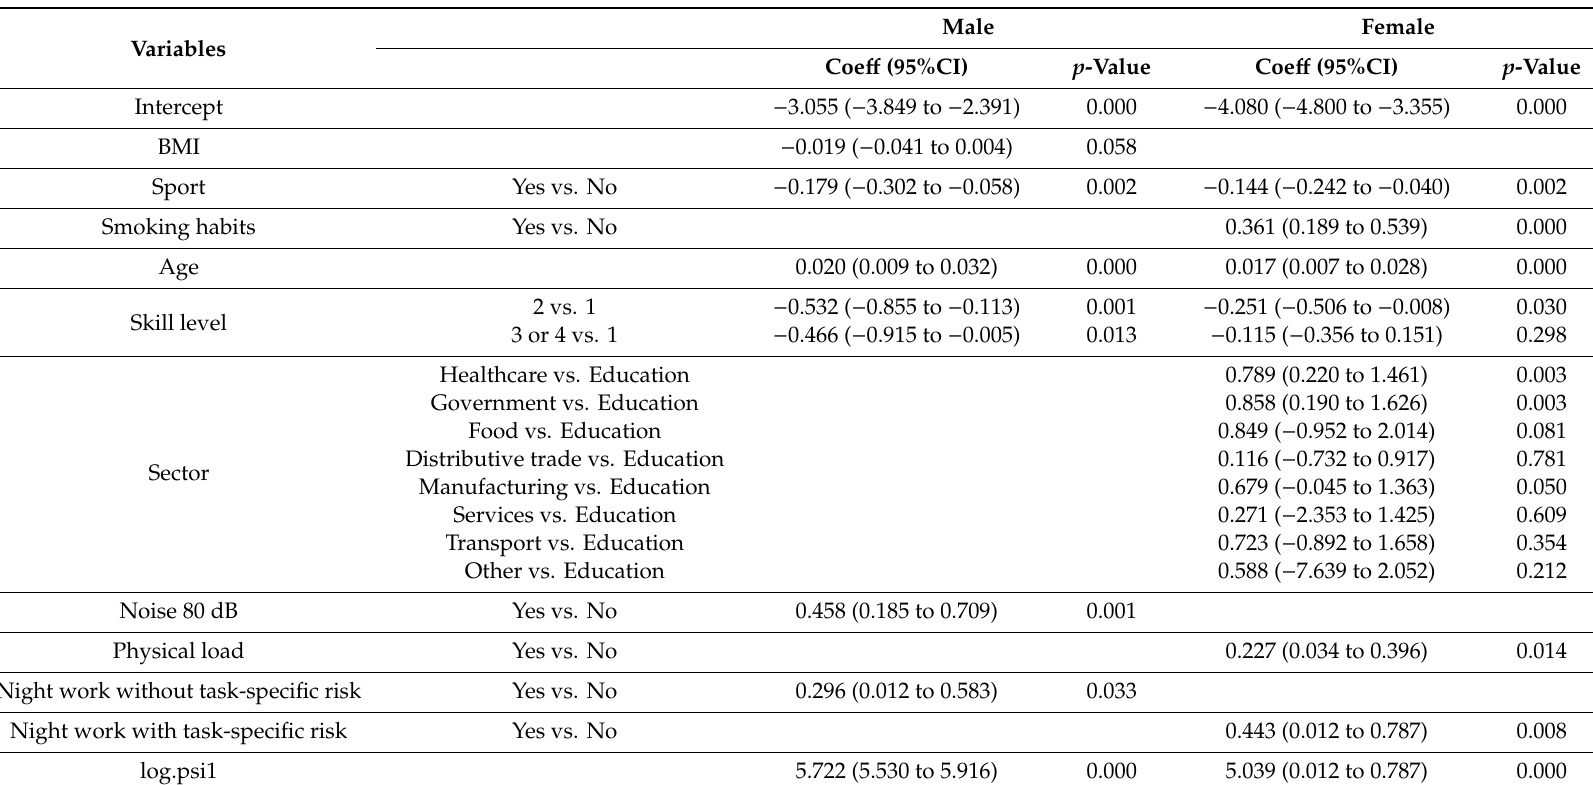
Table 5. Logistic regression model for being on medication for NPD by